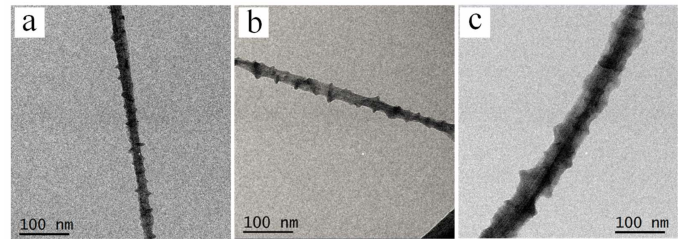
Figure 4. TEM images of PE21M/SWCNT nanocomposites produced at different SC CO 2 pressures: ( a ) 10 MPa, ( b ) 15 MPa, and ( c ) 20 MPa in p -xylene at 50 ◦ C for 3